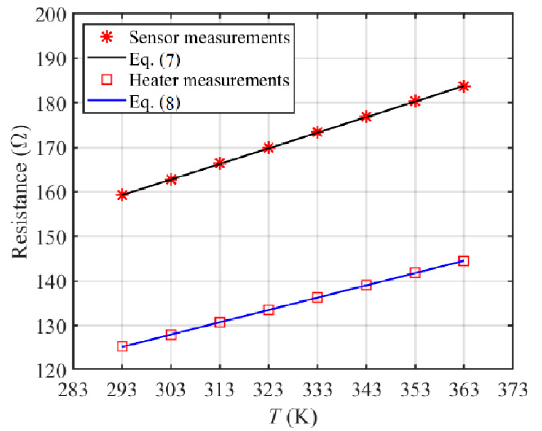
Figure 5. Calibration curves for thin-film Ti/Pt sensors and heaters.